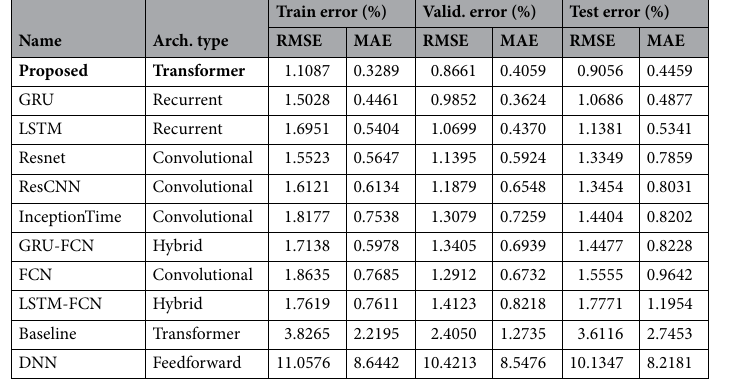
Table 1. SOC estimation accuracy comparison on various DL models on the train, validation, and test dataset at constant ambient